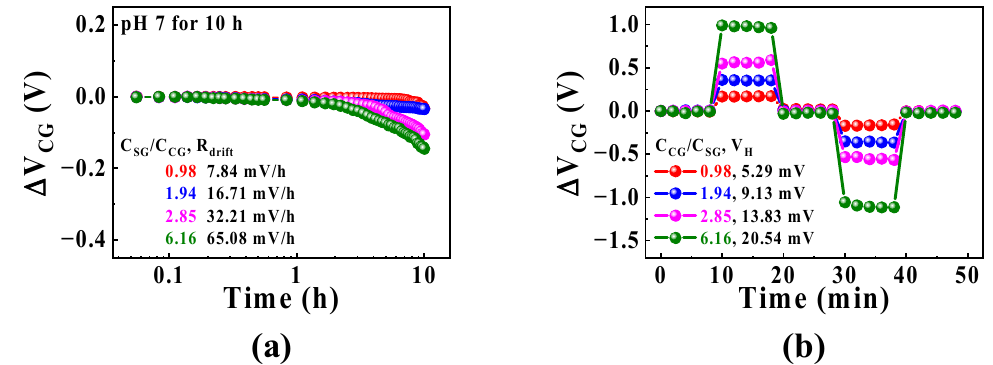
Figure 6. Non-ideal behavior of the a-IGZO coplanar dual-gate TFT pH sensor. ( a ) Hysteresis and ( b ) drift effects for various C SG /C CG values.